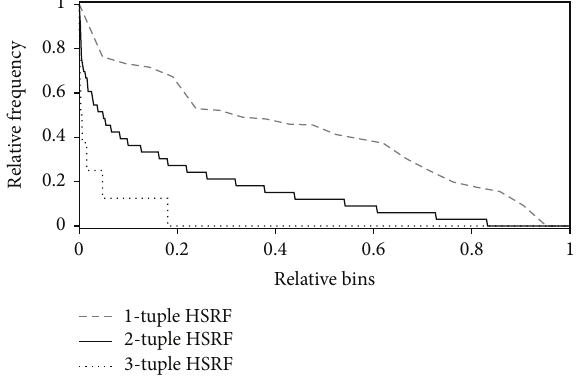
Figure 3: HSRFs of the FINC RAT P04937-4 protein ( 𝑛 = {1, 2,3} ) with normalized horizontal and vertical